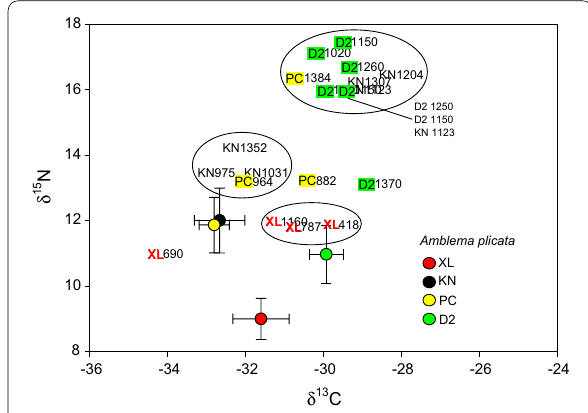
Fig. 7 Isotopic composition (δ 15 N and δ 13 C) of lake sturgeon captured in the Mississippi River near lock and dam 2 (D2) and in the St. Croix River near the Xcel Energy Plant (XL), Kinnickinnic narrows (KN), and near Prescott, Wisconsin, USA (PC). Mean values confidence intervals of δ 15 N (‰) and δ 13 C (‰) in Amblema plicata (circle symbols) , which served as the baseline primary consumer used to estimate the trophic position of the lake sturgeon. Values are not adjusted for trophic